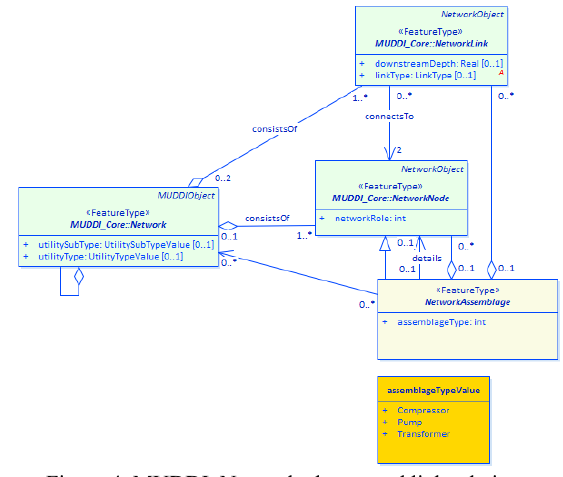
Figure 4. MUDDI_Network classes and link